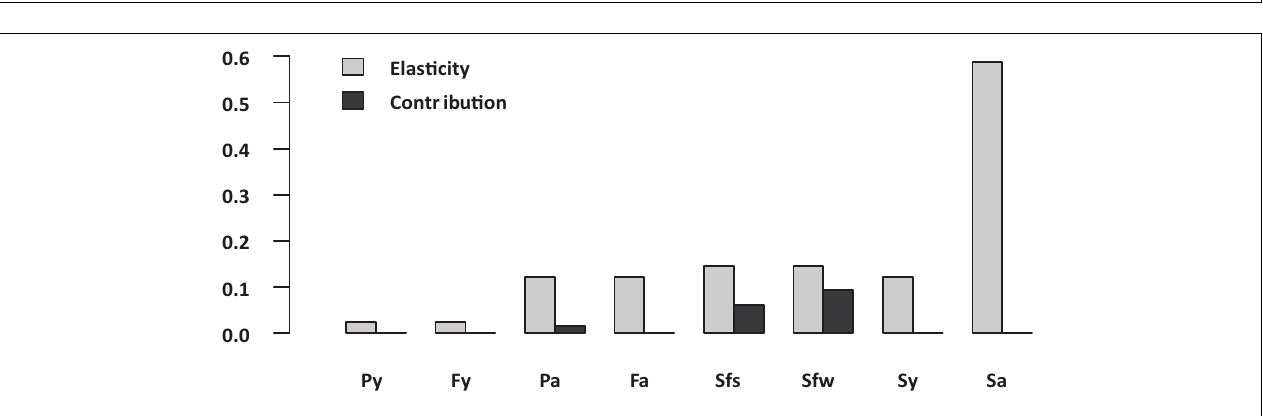
FIGURE 4 | The effects of (A) birth mass of Sitka black-tailed deer fawns on summer survival (0–90 days old), and of (B) occurrence of a severe winter on fawn winter survival (91–365 days old), shown with 95% confidence intervals. The study was conducted 2010–2013, on Prince of Wales Island, AK, United States.